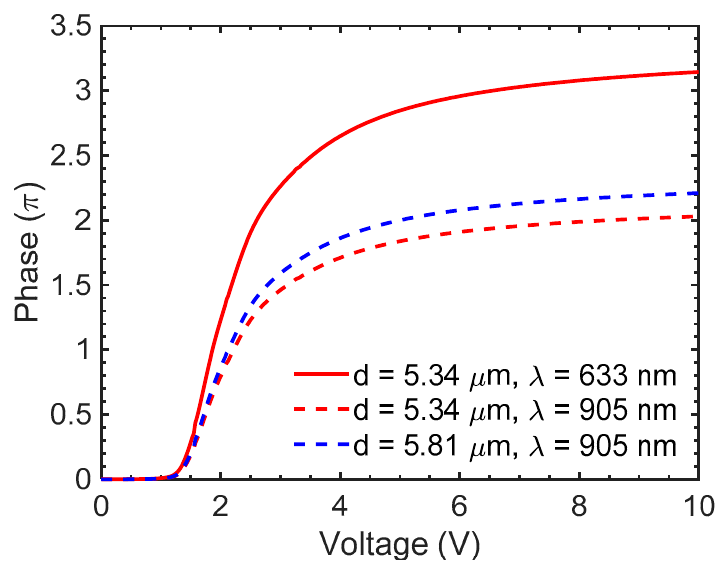
Figure 6. Voltage-dependent phase change of a transmissive A4907 test cell at λ = 633 nm (red solid line, measured) and λ = 905 nm (red dashed line, converted). Cell gap is d = 5.34 μ m at T = 40 ◦ C. To obtain V 2 π = 5 V rms , we should increase the cell gap from 5.34 μ m to 5.81 μ m (blue dashed lines).